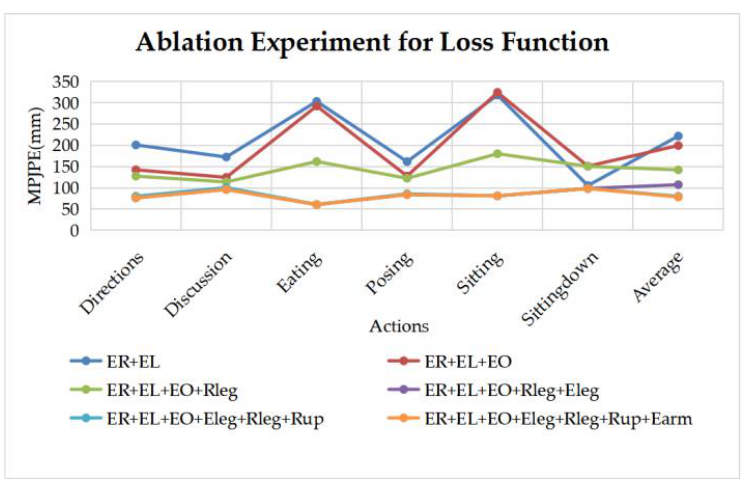
Figure 16. The ablation results of different losses. E R , E L , E O , E leg , E arm are described in Equation (21), Section 3.4; R leg , R up denote the reverse joint correction loss of legs and upper body described in Section